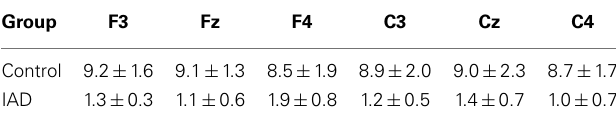
Table 2 | Error-related negativity amplitudes [( µ V) (mean ± SD)] of total error response conditions in IAD group and control